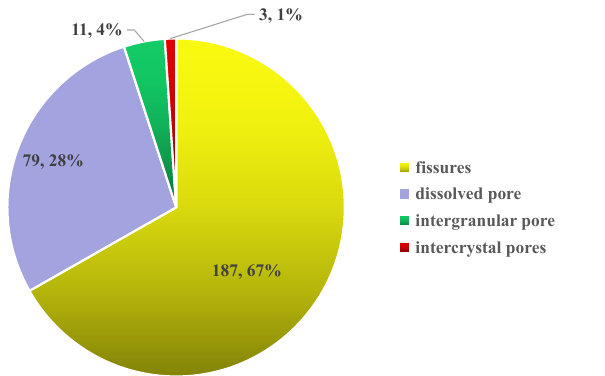
Figure 14. Reservoir pore space types of PL buried-hill. The data were obtained by interpretation of thin sections.